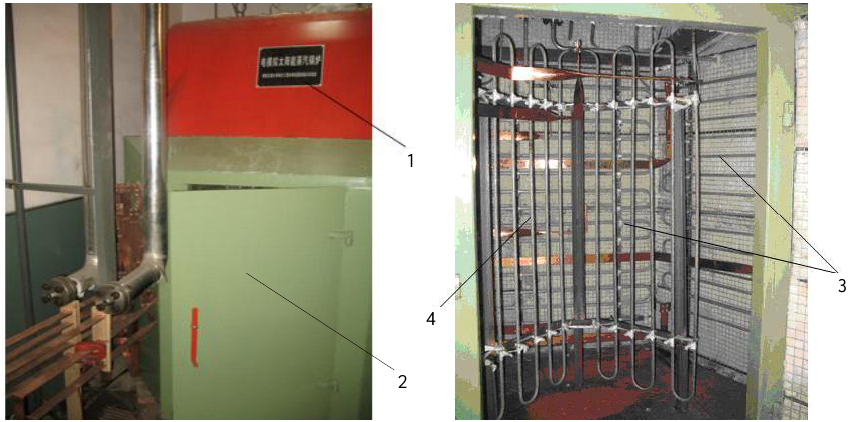
Figure 3. Cavity receiver. (1-drum 2-door 3-boiling tubes 4-superheated